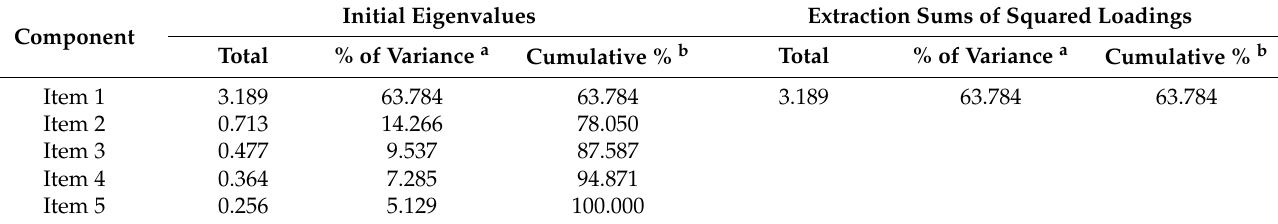
Figure 2. Scree plot for factorial analysis. Table 2. Total variance explained by the factor analysis.